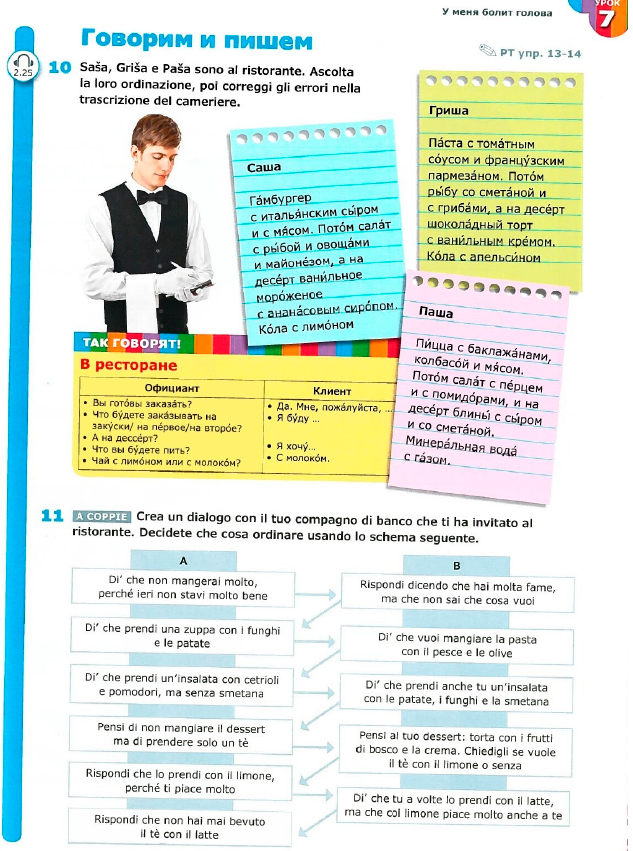
Figure 12. Example 2 of a task in Ura .